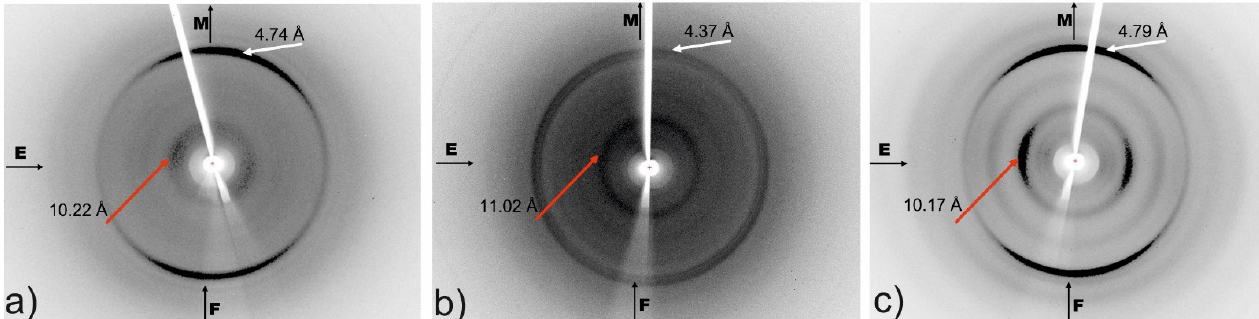
Figure 9. Cross- β signature in the X-ray fiber diffraction patterns. The diffraction patterns were obtained for: ( a ) CysZ4; ( b ) CysZ9 and ( c ) CysZ13 fibers; the position of the strong meridional (M) reflection is highlighted by white arrows, while the position of the strong equatorial (E) reflection is highlighted by red arrows. F–fiber axis.